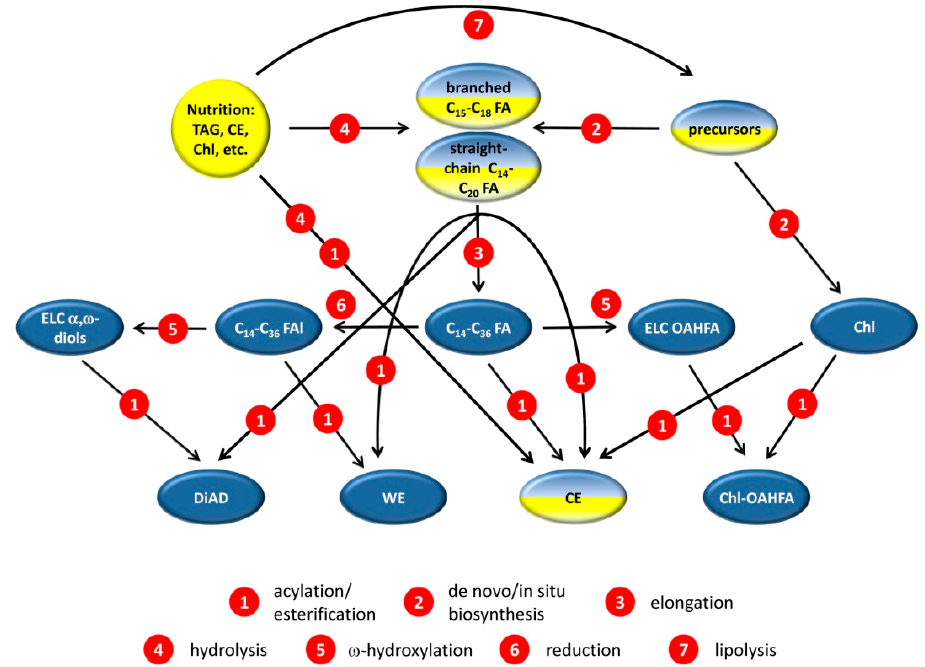
Figure 8. Key steps of meibogenesis. In situ / de novo synthesized lipids are shown in blue, exogenously supplied lipids are shown in yellow; dual coloration indicates a possible mix of exogenously supplied lipids and those that are biosynthesized in meibocytes. Various enzymatic steps are shown in red. Some of the genes and proteins that may be responsible for these steps are listed and discussed in Section 2.4—Results and Section 3—Discussion.